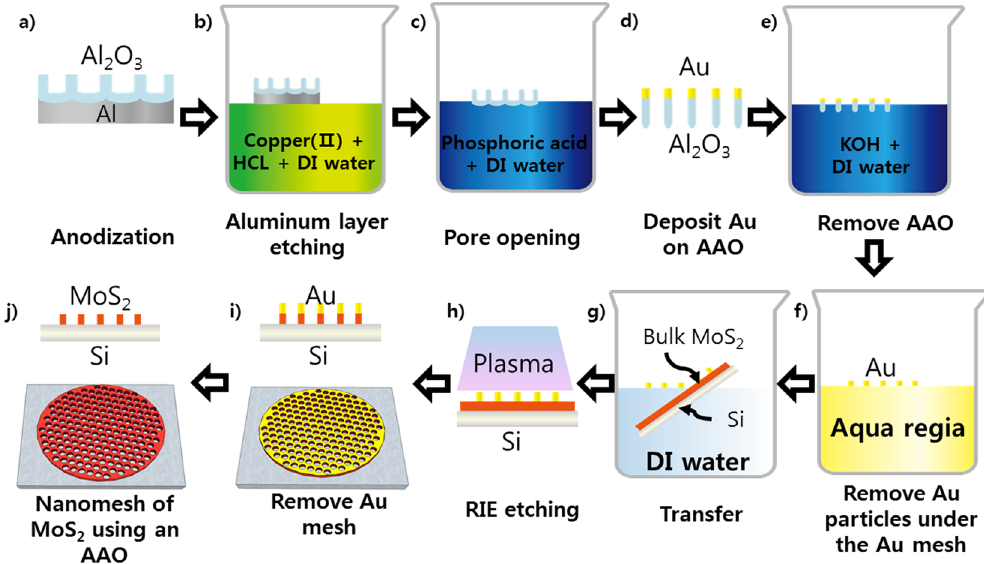
Figure 1. Schematic diagram of the fabrication of a MoS 2